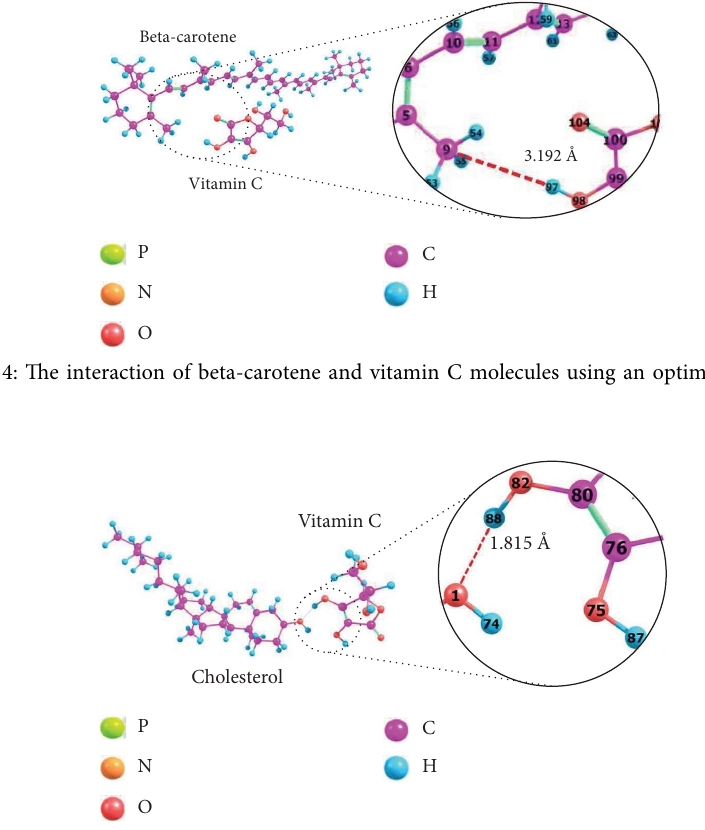
Figure 5: Te interaction of cholesterol and vitamin C molecules using an optimized Table 3: Te cholesterol ∗∗∗ and vitamin C ∗∗ atoms’ partial atomic charges before and after the interaction.